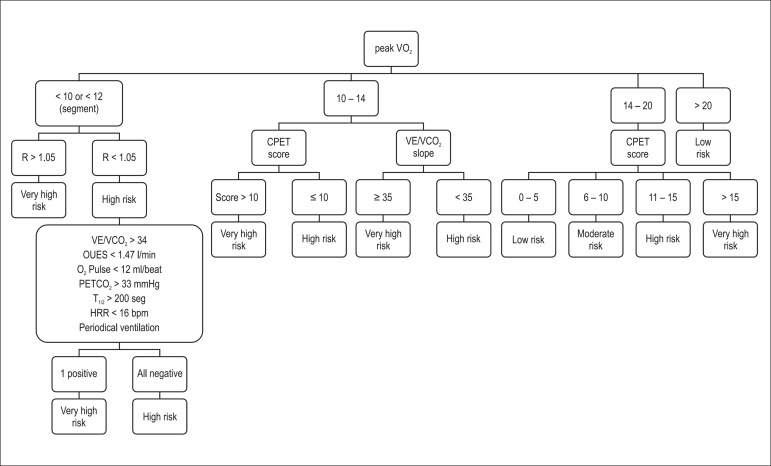
Risk stratification based on CPET results from patients with CHF
(Modified from Ribeiro JP, Stein R, Chiappa GR. J Cardiopulm
Rehabil. 2006 Mar- Apr;26(2):63-71). CPET: cardiopulmonary exercise
test; VO2 : oxygen consumption; R: respiratory exchange
ratio; VE/VCO2 slope: ratio between pulmonary ventilation
and carbon dioxide production; PETCO2 : extrapolated
end-tidal carbon dioxide tension; T1/2 : time necessary
for a post-exertion 50% drop in VO2 measured; OUES:
oxygen uptake efficiency slope; HRR: heart rate recovery.